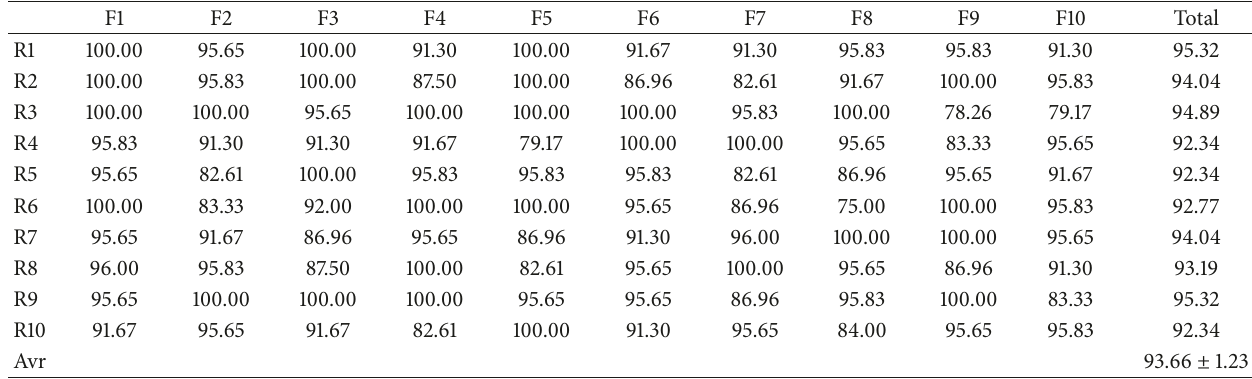
Table 5: Accuracy of the proposed method (unit: %).